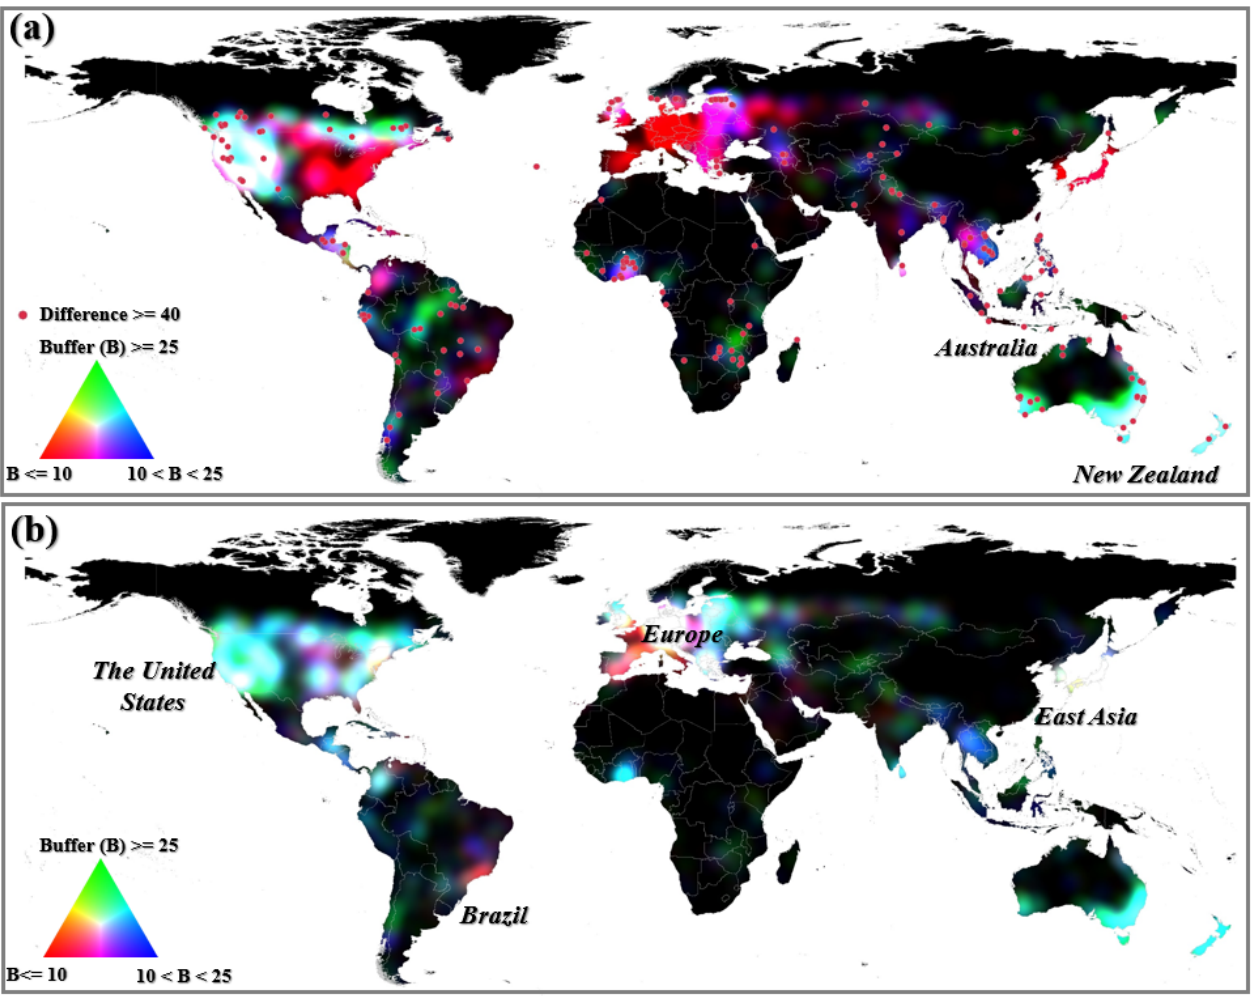
Figure 6. The distance of PAs to the averaged first (a) and high-intensity (b) polluted buffers. The visualization of maps is composited by channels of distance to buffers (buffer <= 10, R; 10 < buffer < 25, G; buffer >= 25, B). Those red points with distances beyond 40 km are mainly caused by unstable light sources (e.g., ports, logging, and shipping).